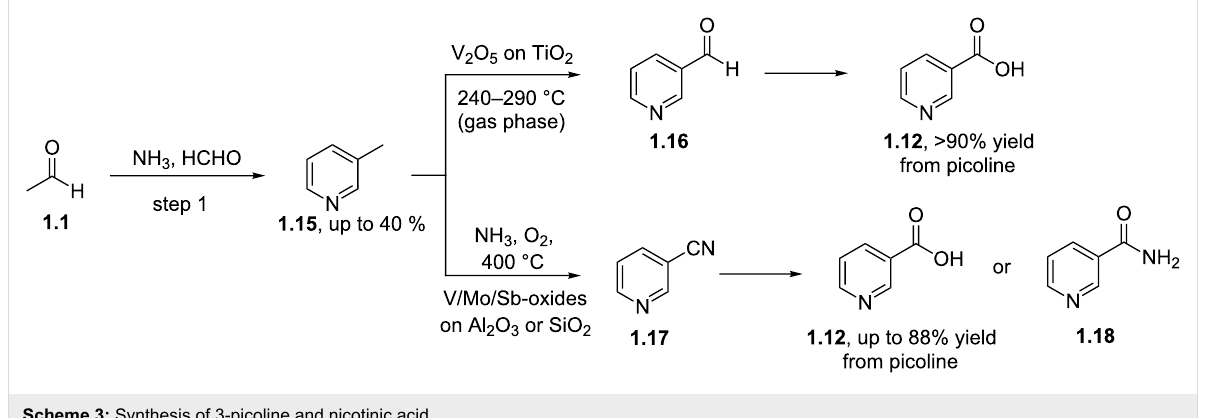
Scheme 3: Synthesis of 3-picoline and nicotinic